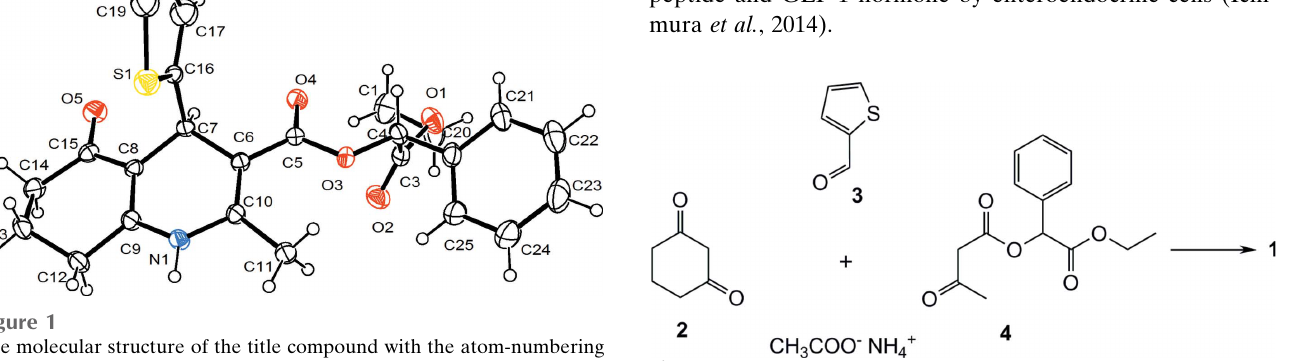
Figure 3 Reaction scheme for the title compound 1 .